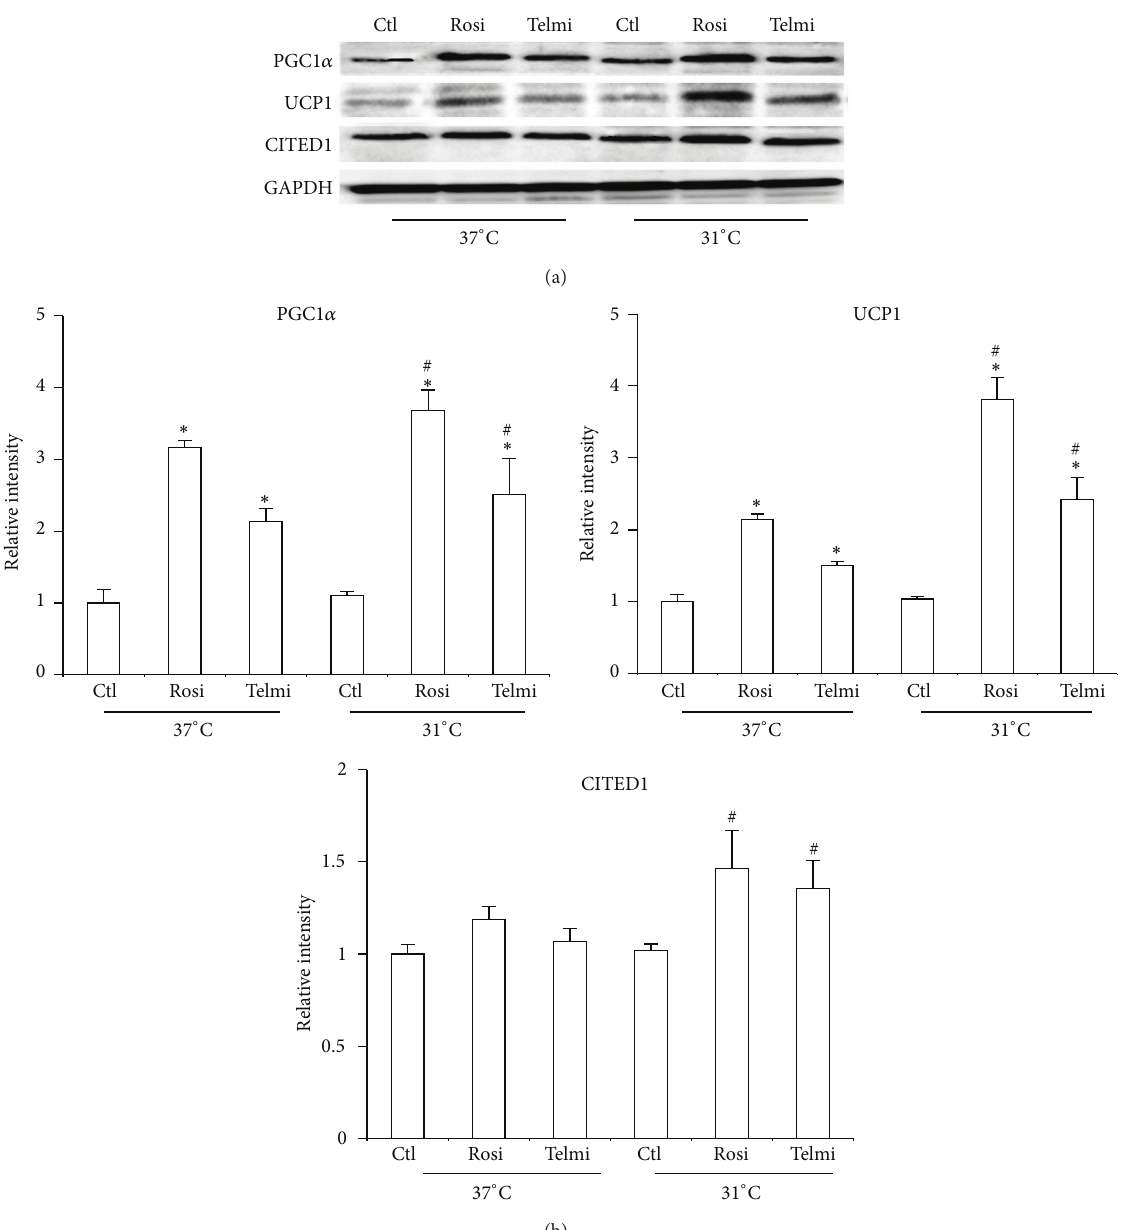
Figure 2: Effect of cold and full and partial agonists in the adipocyte phenotype. (a) Differentiated adipocytes were obtained and treated as described in Figure 1; total protein was isolated for detecting expression of PGC1 𝛼 , UCP1, and CITED1 using western blot. (b) Relative intensity levels were determined by densitometry of bands. Analyses were performed using ANOVA test. Data are expressed as mean ± SD and differences were considered 𝑃 < 0.05 . ∗ Differences between total and partial agonist in relation to control. # indicates meaningful differences observed after 4 hours of treatment with agonists after exposure to cold in comparison with adipocytes treated in equal conditions at 37 ∘ C. Data were normalized with